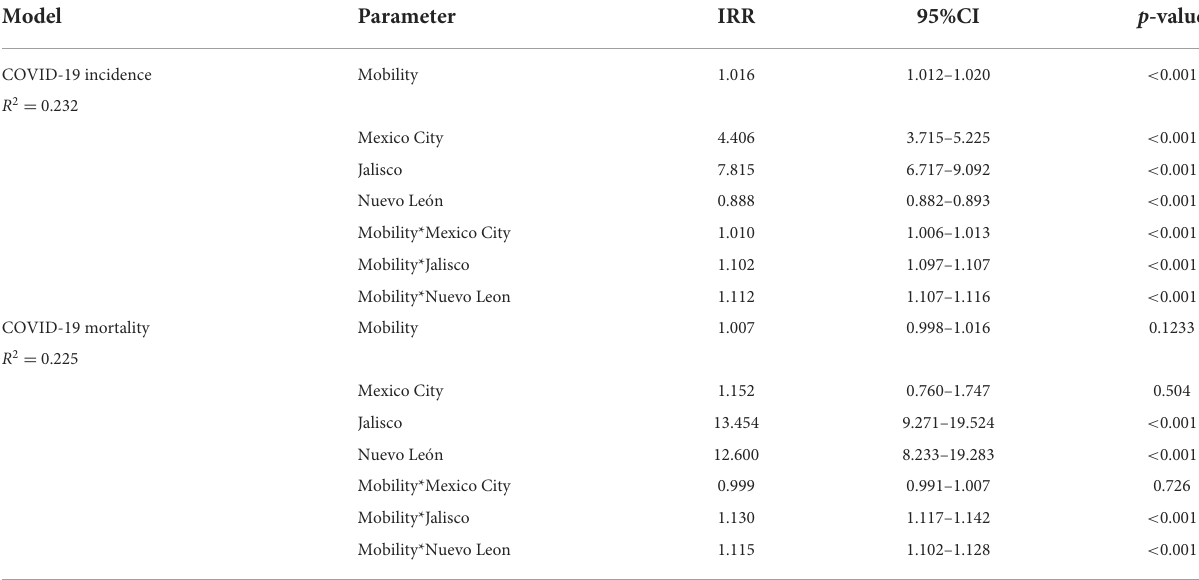
TABLE 4 Results from mixed-effects Poisson regression models to evaluate the influence of mobility on the incidence of positive COVID-19 cases and COVID-19 mortality rates per state using an interaction effect and using as reference the state of Baja California.